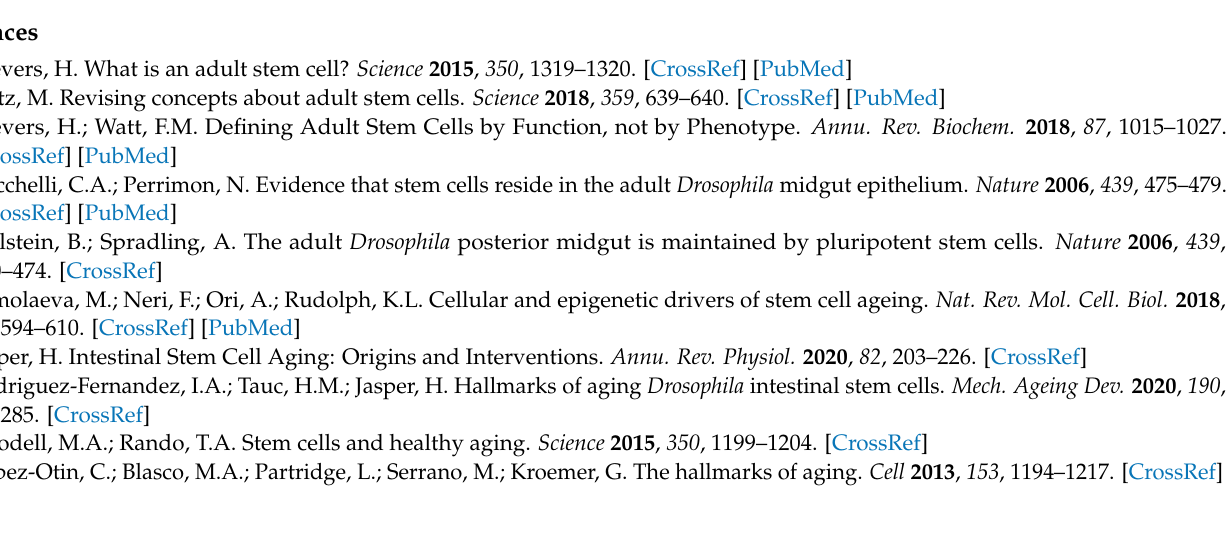
apoptosis. Figure S2: The effect of Que on the number of ECs or EEs in stress stimulated flies. Figure S3: RT-qPCR analysis of the antioxidant-related genes in the midgut of 14-day-old flies. Figure S4: RT-qPCR analysis of the insulin signaling-related genes in the midgut of 14-day-old flies. Table S1: The list of the Drosophila genotypes; Table S2: The list of the primary antibodies; Table S3: The list of the primers. Table S4: The list of gene accession numbers for all the genes used in Figure 5. Table S5: The list of the top 30 genes upregulated and the top 30 genes downregulated in Que-treated 40-day-old flies compared to the control